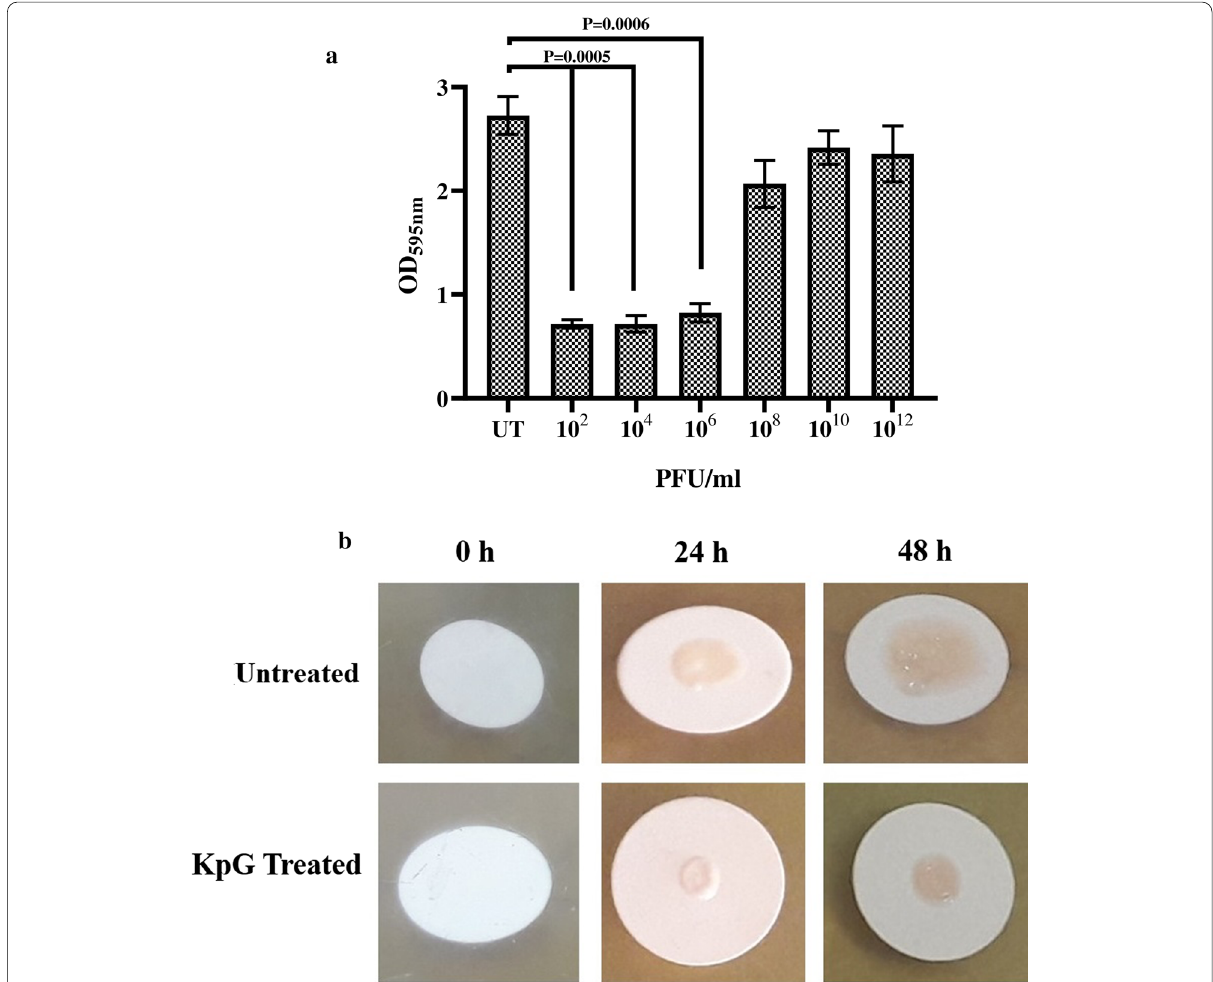
Fig. 5 KpG phages efficiently inhibited biofilm formation of K. pneumoniae at liquid–air and at solid-air interface. a) Biofilms were formed in micro titer plates with or without KpG phages and washed with PBS. 24 h post treatment, Crystal violet was added and after 15 min, the unbound crystal violet was removed and the stain was extracted by acetic acid and the absorbance was measured at 595 nm, b) Membrane filters were placed on BHI agar and inoculated with bacteria with or without KpG. The ability of phages to decrease biofilm formation can be examined visually till 48 h. Images are representative of three independent